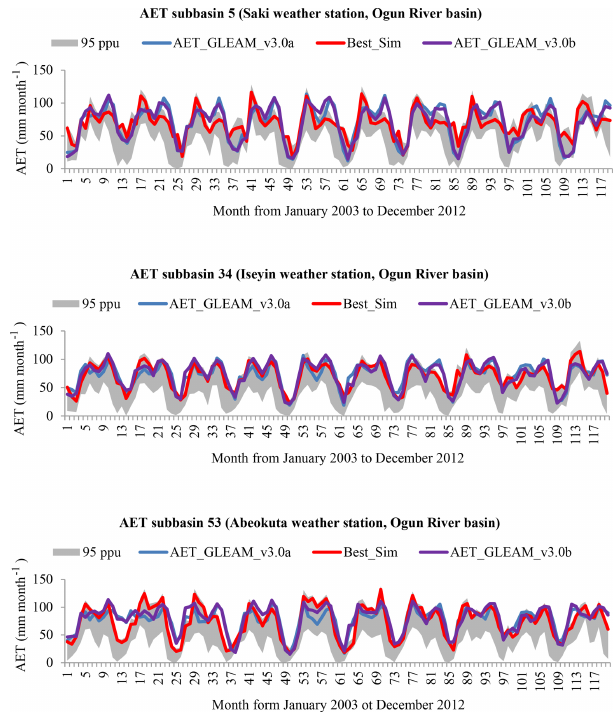
Figure 11. SWAT model verification results showing the satellite- based AET GLEAM_v3.0a used for the model calibration and val- idation, the best SWAT-simulated actual evapotranspiration (GS1) and an independent GLEAM_v3.0b time series bracketed by 95% predictive uncertainty.